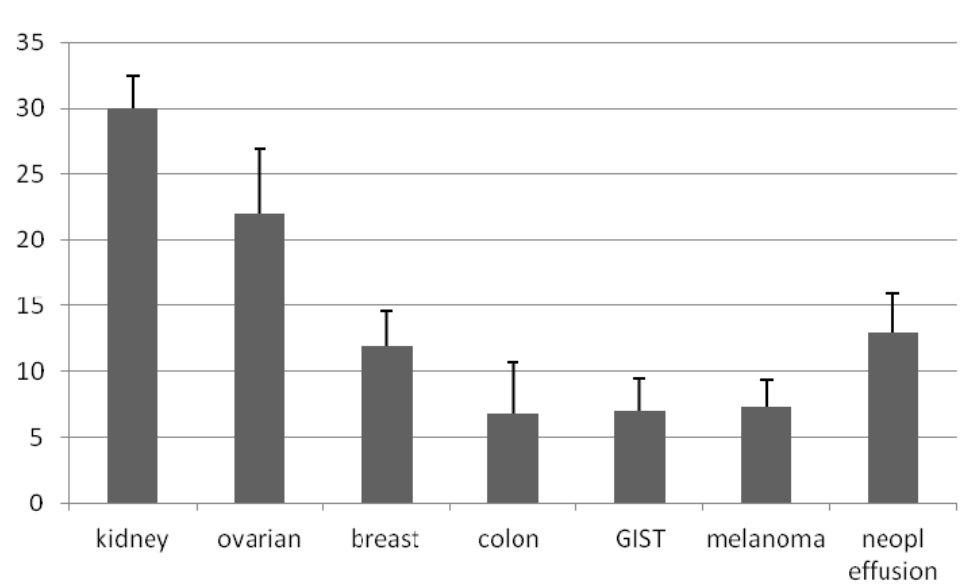
Figure 1. Growth potential of primary cell cultures from different solid tumors and neoplastic effusions (average of